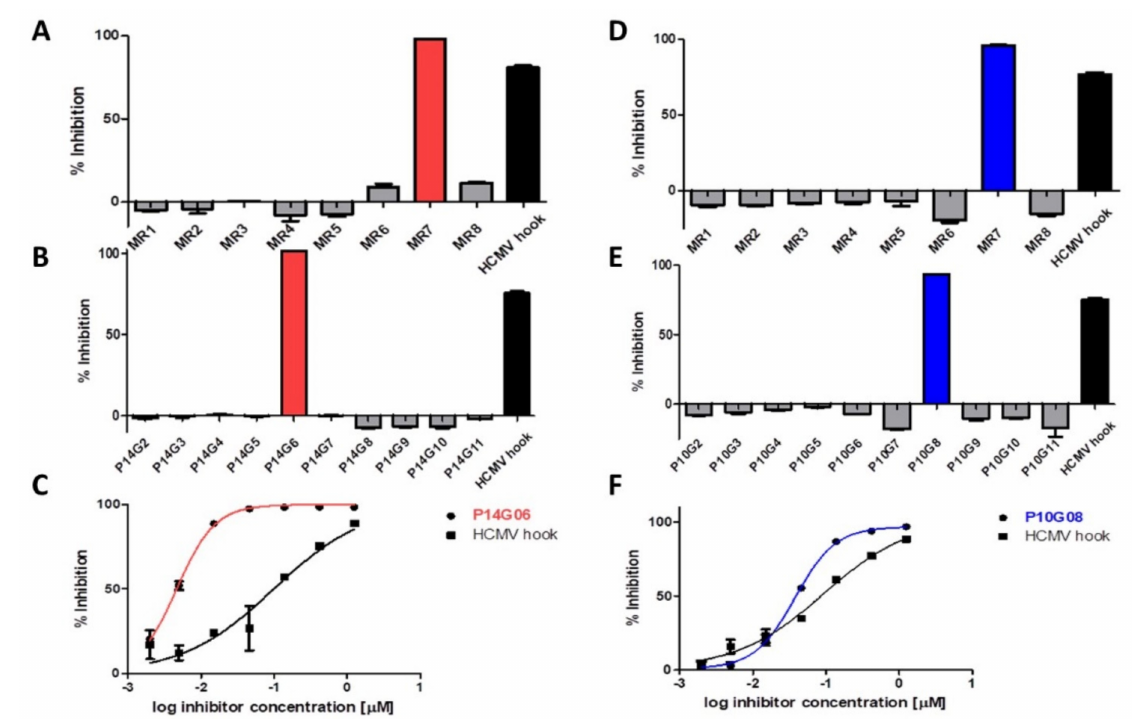
Figure 2. Identification of the most active inhibitors of the pUL50-pUL53 interaction from plate mixtures MP14 (left) and MP10 (right). ( A , D ). Screening of the row mixtures of plate 14 ( A ) and plate 10 ( D ). ( B , E ) Inhibition of the pUL50-pUL53 interaction by the individual compounds making up the most active row mixtures of plate 14 ( B ) and plate 10 ( E ). ( C , F ) Dose-dependent inhibition of the pUL50-pUL53 interaction by the most active inhibitors (P14G06 and P10G08), compared with the peptide presenting the N-terminal helical hook of HCMV pUL53 (HCMV hook). Error bars present SEMs of at least two experiments. See Section 2.1 for experimental